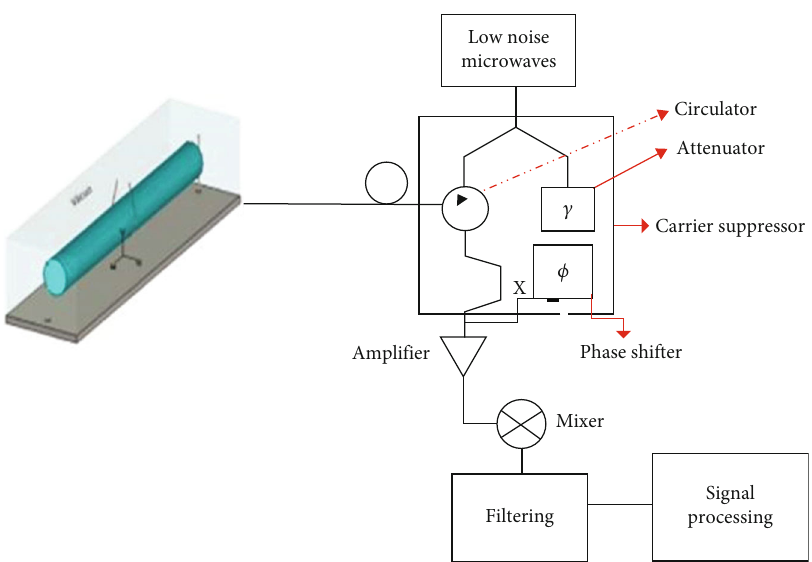
Figure 7: The experiments microwave electronics. Source: from the authors.